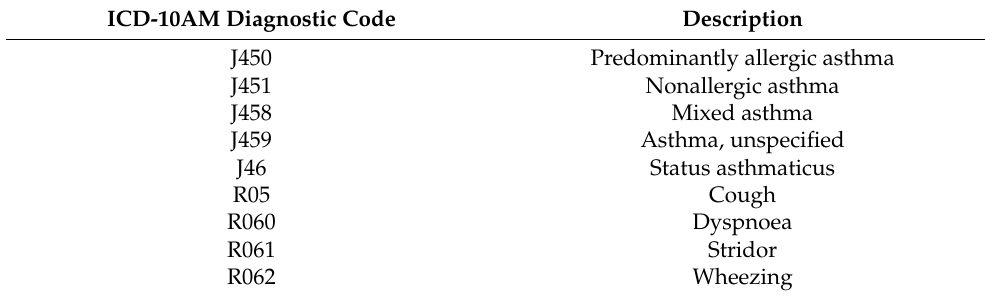
Table 1. Diagnostic codes and